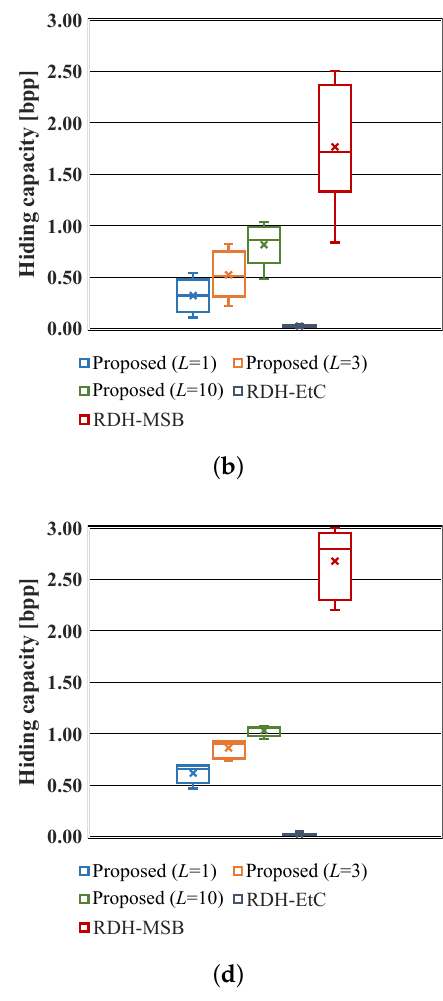
Figure 13. Data hiding capacity of proposed, RDH-EtC [30] and RDH-MSB [29] methods. ( a ) Kodim4; ( b ) peppar; ( c ) ihc5 (1/16); ( d ) ihc5